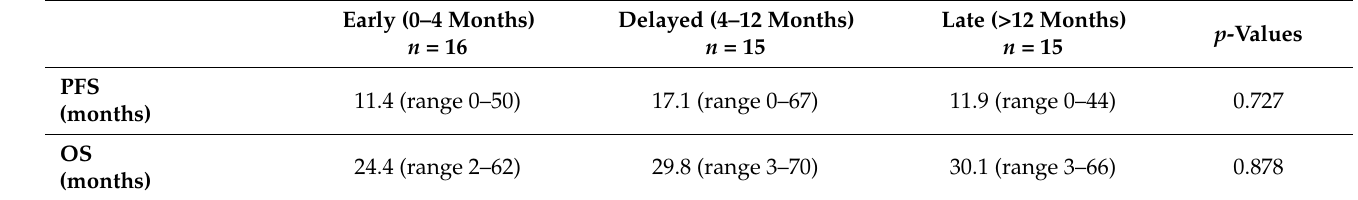
Table 2. PFS and OS are shown for patients who developed lymphopenia depending on the time- point of occurrence of lymphopenia. Early is defined as the onset of lymphopenia between the beginning of ICI therapy and up to 4 months after. Delayed is defined as the onset of lymphopenia between 4 and 12 months after the beginning of ICI therapy. Late is defined as the onset of lymphope- nia more than 12 months after the beginning of ICI therapy. The three groups were compared with regard to PFS ( p = 0.727) and OS ( p = 0.878). ICI: immune checkpoint inhibitor.